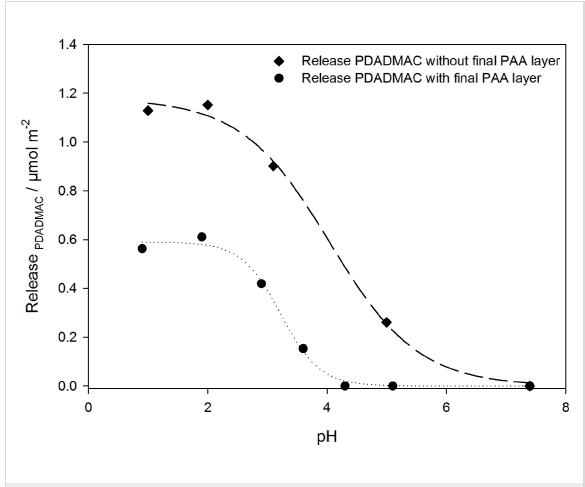
Figure 6: Released amount of PDADMAC per surface area in depend- ence of the pH. The amount of released PDADMAC was related to the total particle surface to yield the released amount per surface